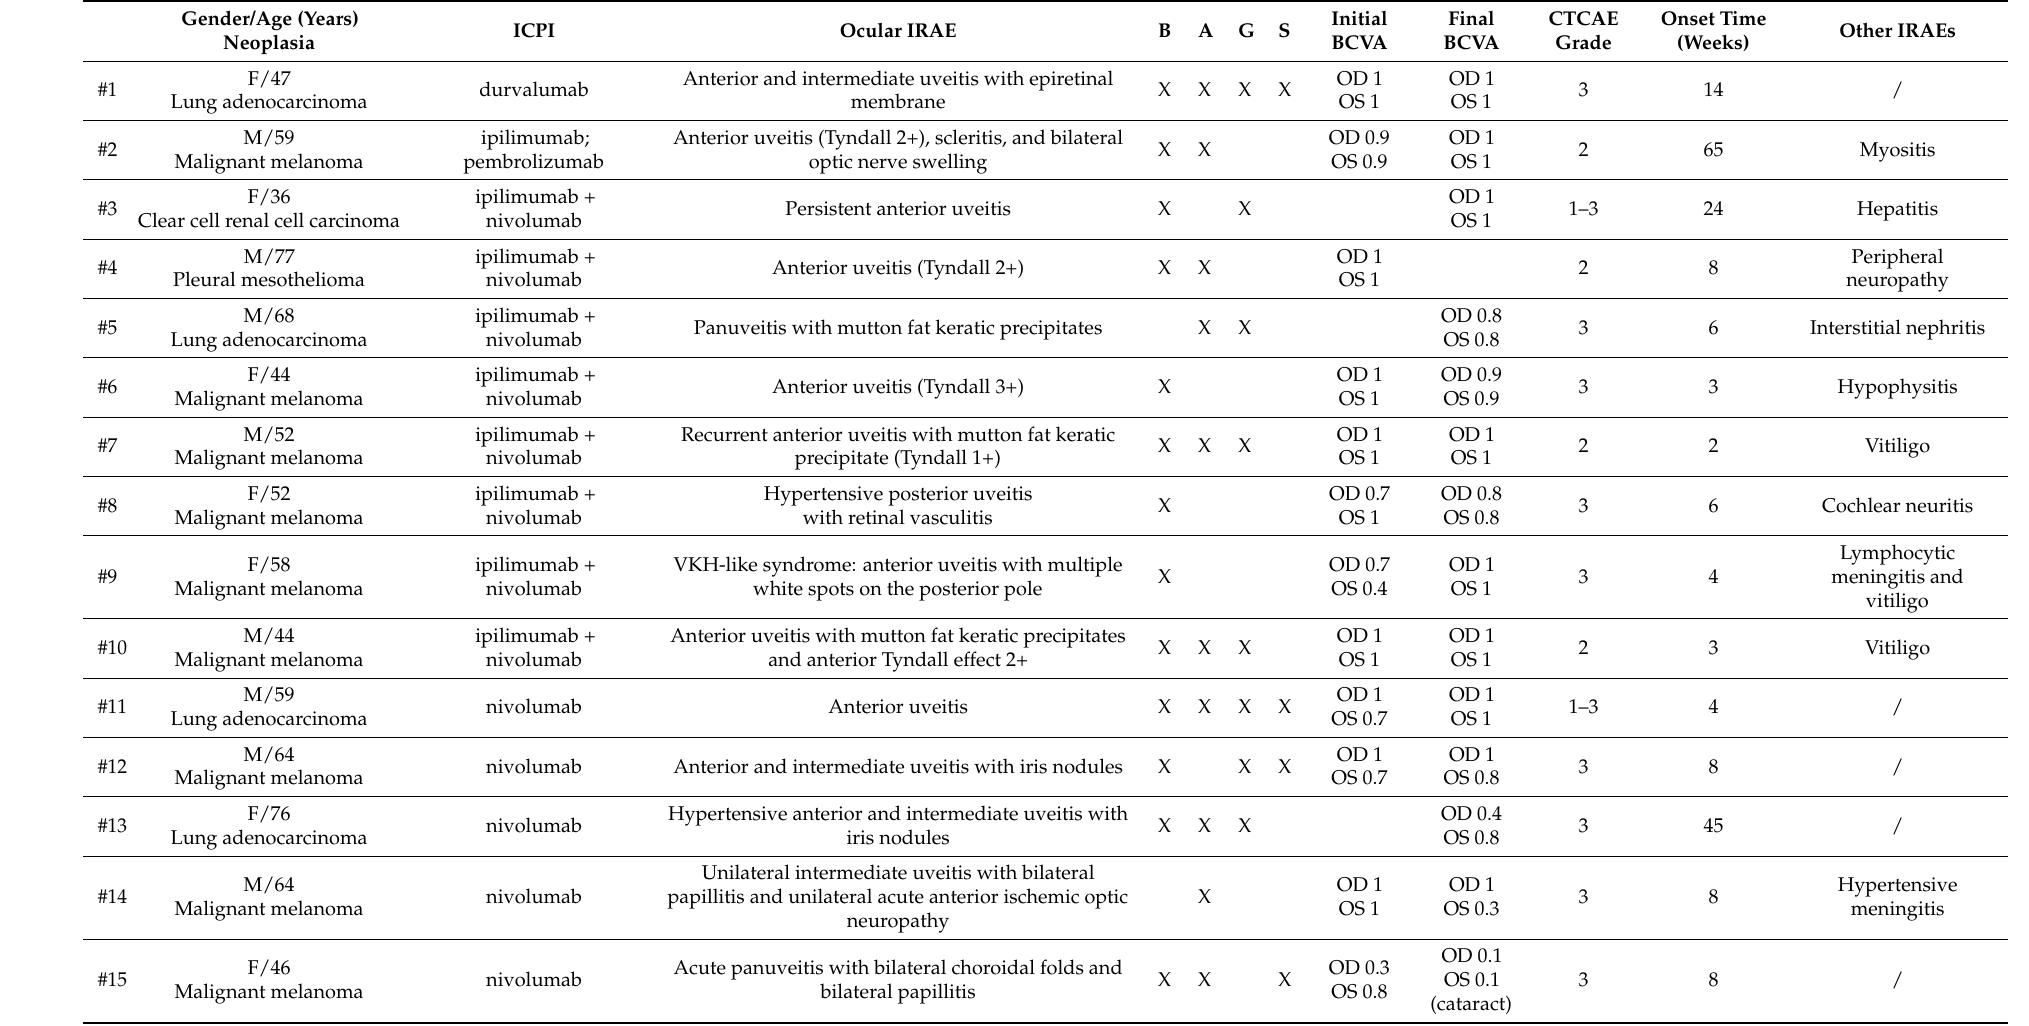
Table 3. Detailed ocular findings in patients with ICPI-induced